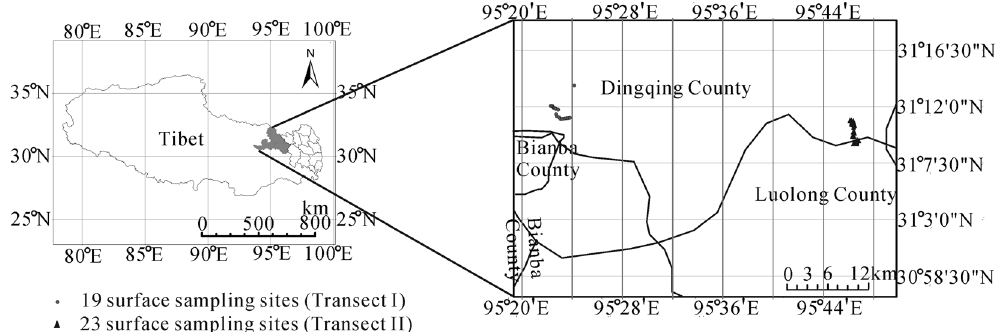
Figure 1. Surface pollen samples sites along an altitudinal gradient from Dingqing county in Tibet, China (Chinese map in the figure was created by ArcGIS 9.3 software, http://www.arcgis.com/features/).“Scientific Reports remains neutral with regard to jurisdictional claims in published